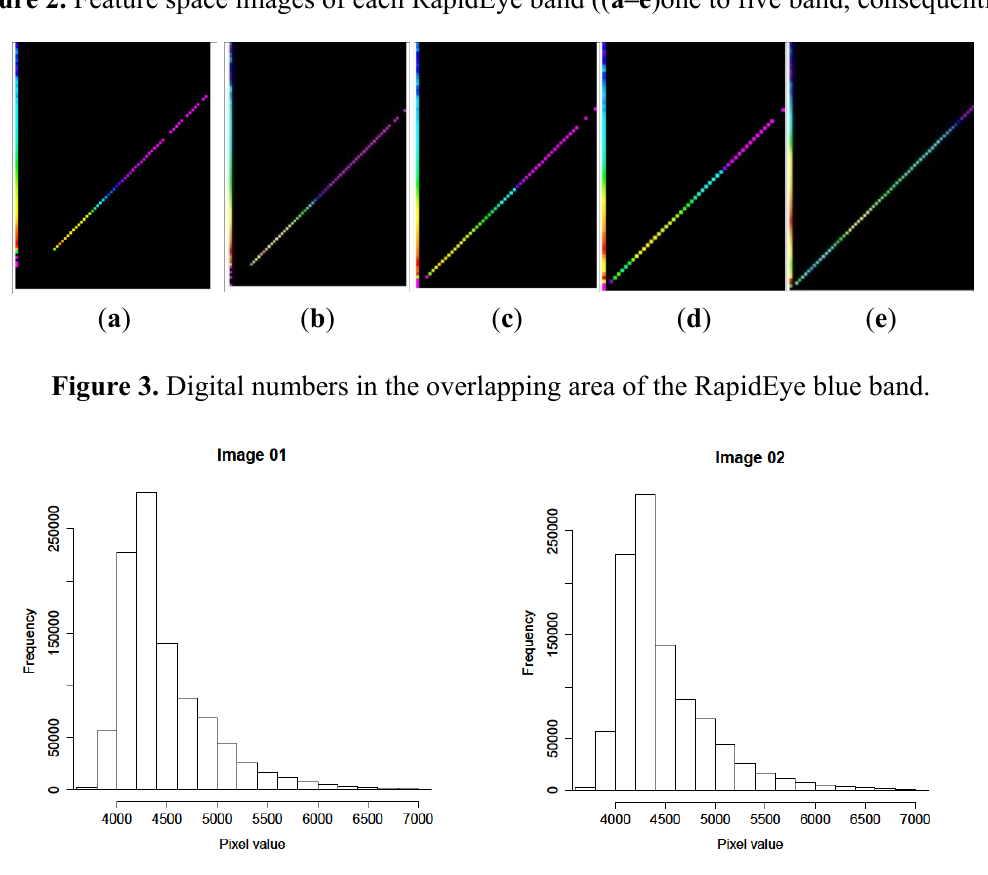
Figure 2. Feature space images of each RapidEye band (( a–e )one to five band, consequently).